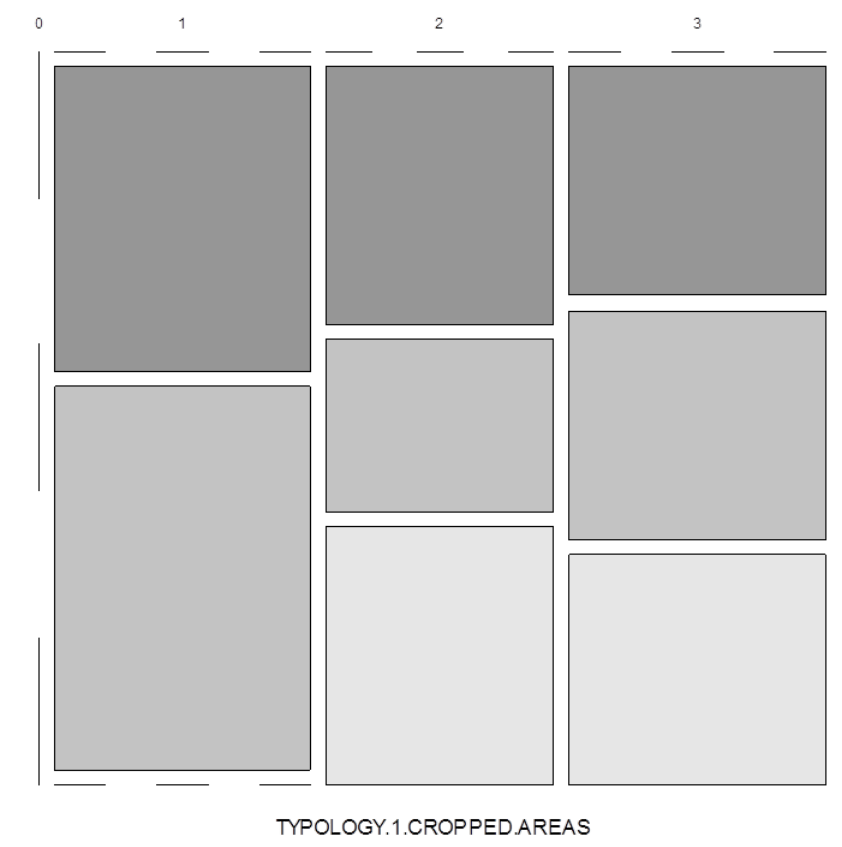
Figure A1.3 Comparison of the distributions of farmers between groups based on cropped land management practices similarities and groups based on semi-natural area management practices similarities. Fisher Exact Test for Count Data p- value =